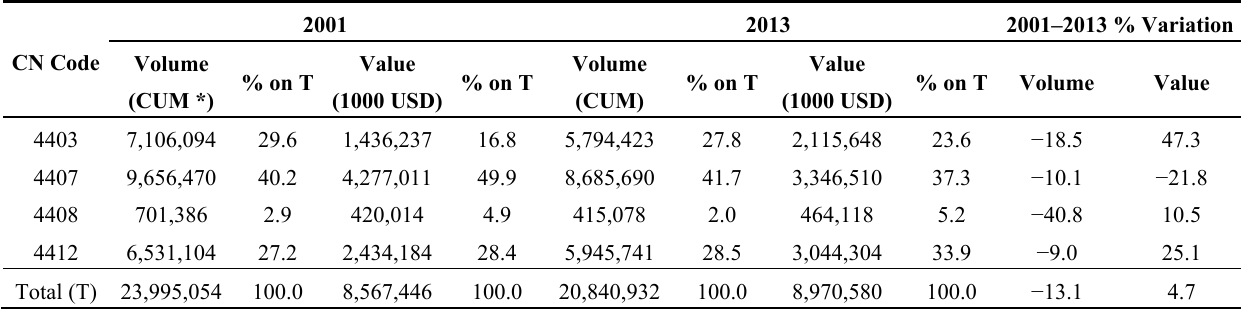
Table 3. International tropical timber trade—in volume and value—for selected product groups, 2001 and